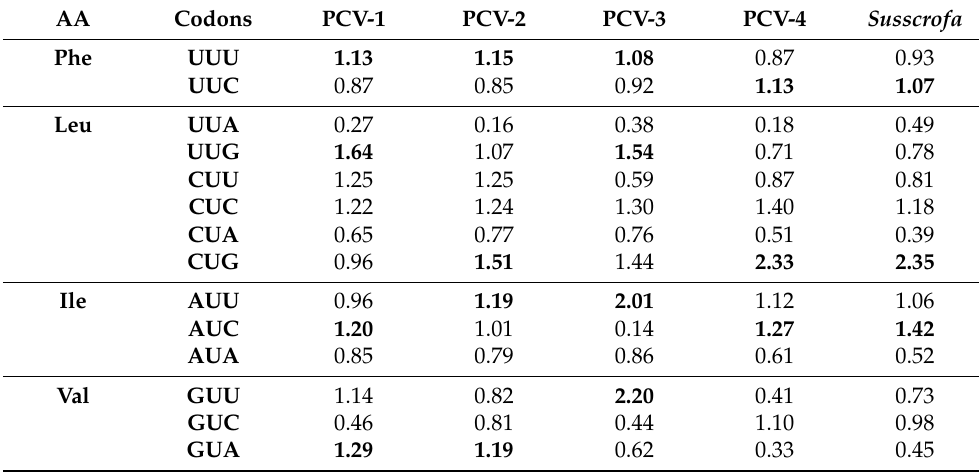
Table 2. RSCU values of different PCV species and its host Sus scrofa